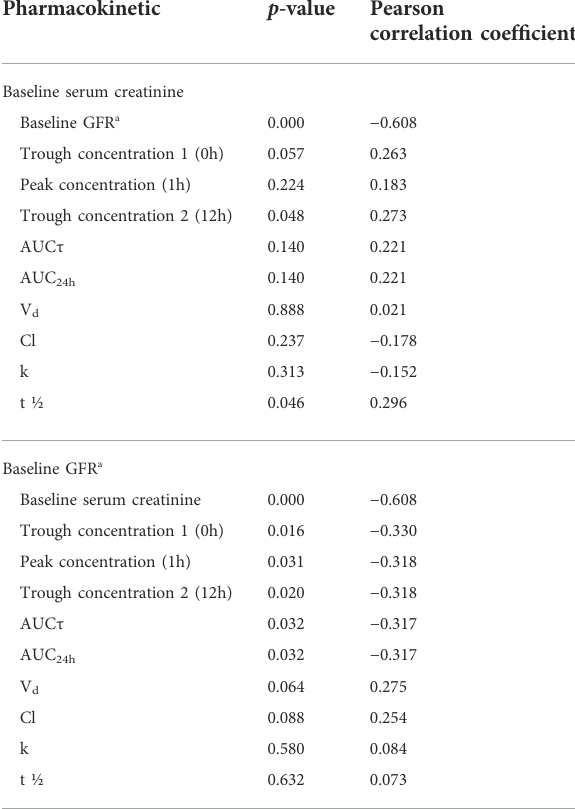
TABLE 2 Pharmacokinetic parameters after vancomycin administration at steady-state condition. Pharmacokinetic parameters